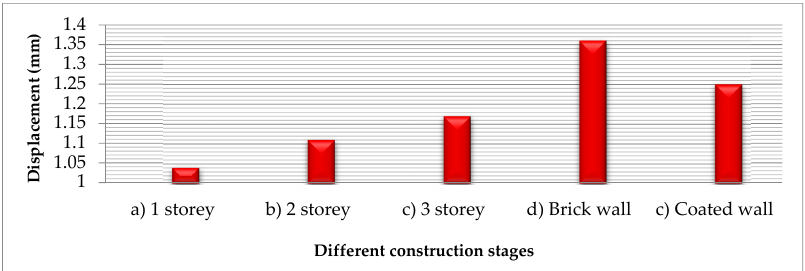
Figure 5. Comparison between ultimate displacements at different construction stages.